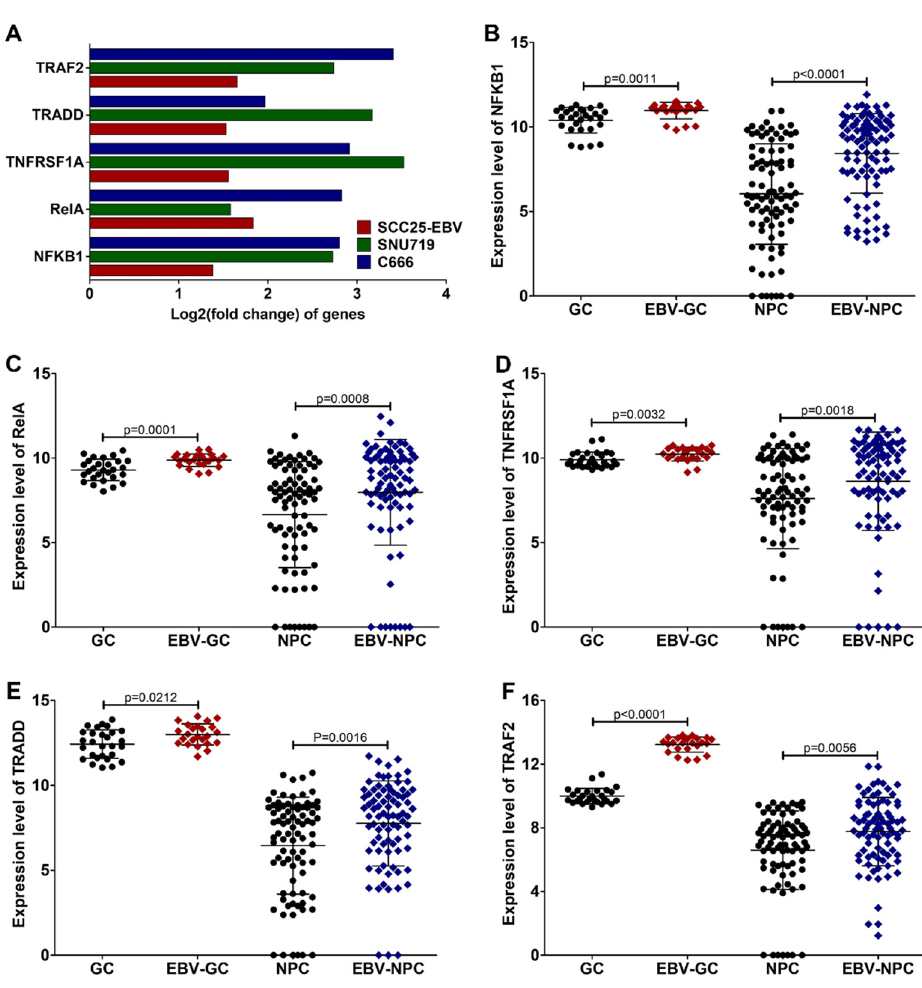
Figure 8. Key genes in the TNF- α /NF- κ B signaling pathway are upregulated in EBV-associated epithelial cancers. The expression of key genes in the TNF- α /NF- κ B signaling pathway was determined in EBV-infected cells ( A ). In the tumor tissues, the expression of NFKB1 ( B ), RelA ( C ), TNFRSF1A ( D ), TRADD ( E ), and TRAF2 ( F ) was also examined.